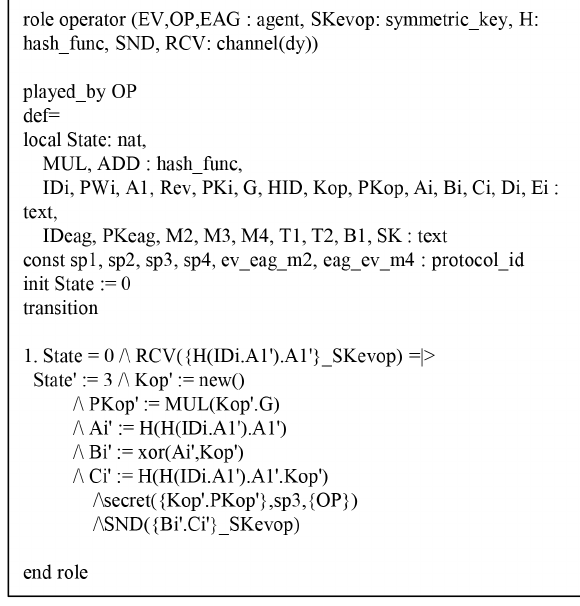
Figure 11. Specification of the